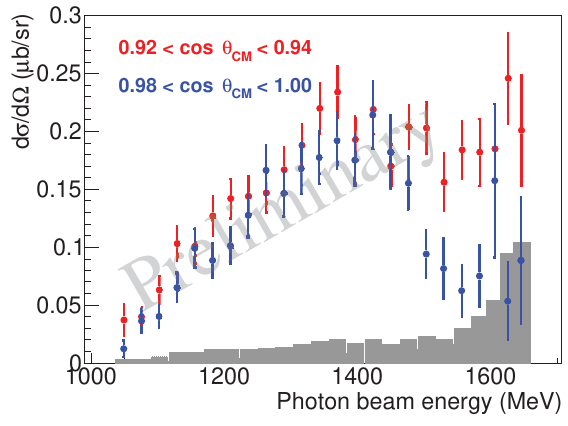
Figure 18. γ p → K + Λ recoil polarisation for cos K + points). Previous data shown from McCracken et al. [40], Lleres et al. [43] and the Bonn-Gatchina PWA solution [44] shown in red triangles, purple triangles and magenta line respectively.